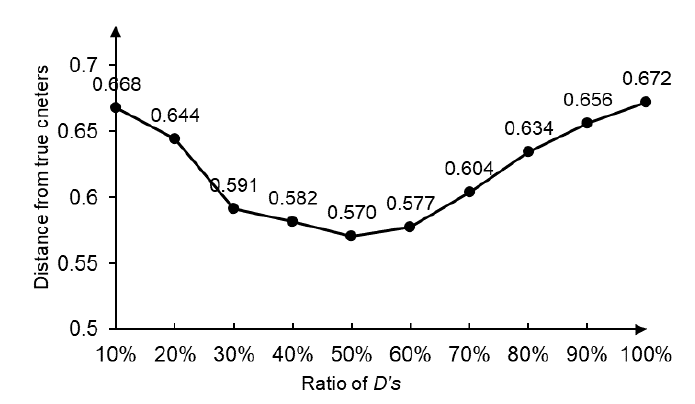
Figure 2. Variation of distance between true centers and clustering